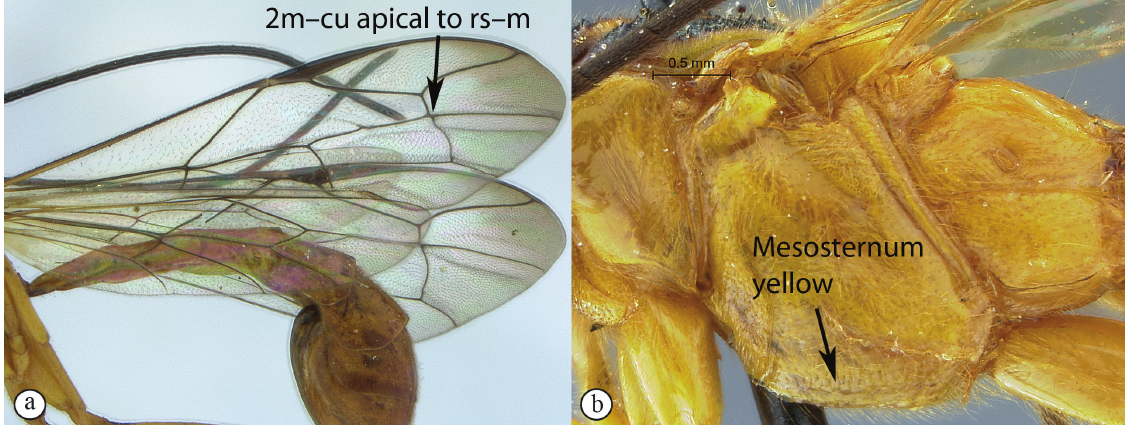
- Fore wing with 2m–cu apical to rs–m (a); mesosternum yellow (b) ………………………11